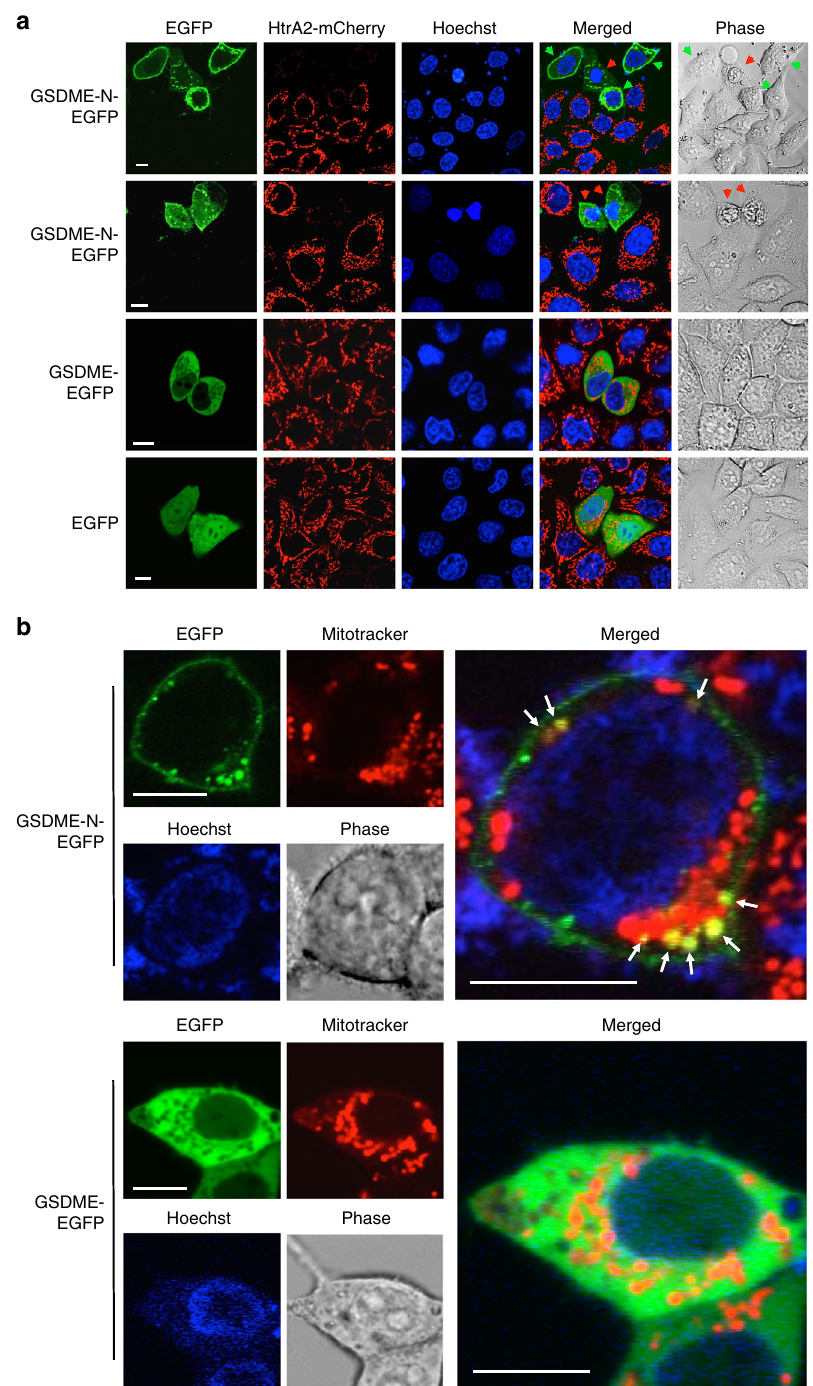
Fig. 4 GSDME-N localizes to mitochondria and releases proapoptotic proteins. a Confocal live-cell imaging of GSDME-N-EGFP (1st and 2nd rows), GSDME-EGFP (3rd row), and EGFP (4th row) expressed in HeLa cells stably reconstituted with mCherry-tagged mitochondrial HtrA2. The green arrows indicate non-pyroptotic cells, and the red arrows indicate pyroptotic cells. b Confocal live-cell imaging of MitoTraker red-stained 293T cells after transfection with GSDME-N-EGFP (upper panels), or full-length GSDME-EGFP (lower panels). The green channels show the expression of GSDME-N-EGFP (upper left), or GSDME-EGFP (lower left). The red channels show mitochondrial staining with MitoTracker red. The merged channels are shown on the right. The arrows (upper right) indicate the co-localization of GSDME-N-EGFP with MitoTracker red. Results are representative of at least three independent experiments. Scale bar, 10 µ GSDME-N-EGFP-expressing HEK293T cells (Fig. 4b, upper decrease mitochondrial membrane potential. The full-length panels). Moreover, the MitoTracker Red signal was weaker in GSDME-EGFP showed cytosolic distribution and did not co- areas that overlapped with GSDME-N-EGFP, which is consistent localize with MitoTracker red (Fig. 4b, lower panels), indicating with the ability of mitochondrial pore-forming proteins to that cleavage of GSDME is necessary for mitochondrial targeting.